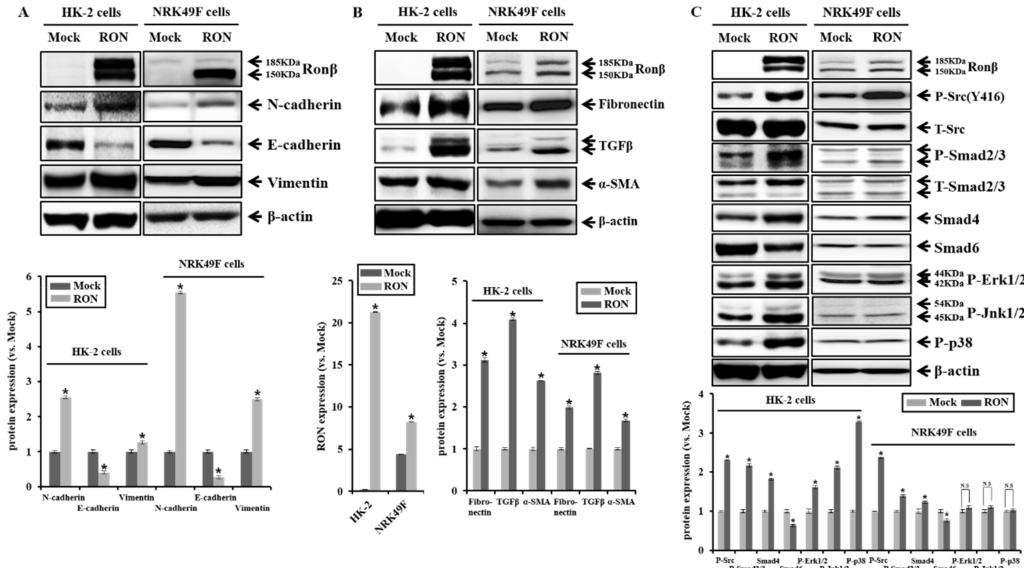
Figure 2. E ff ects of recepteur d’origine nantais (RON) overexpression on EMT, pro-fibrotic marker, and the Src signaling pathway in HK-2 and NRK49F cells. ( A ) Protein expression of the N-cadherin, E-cadherin, and vimentin by RON overexpression was analyzed. ( B ) Protein expression of fibronectin, TGF β , and α -SMA by RON overexpression was analyzed. ( C ) Protein expression of phosphorylated Src (Y416) was assessed in RON overexpression and controls. Protein expression of the phosphorylated Smad2 / 3, Smad4, and Smad6 by RON overexpression was analyzed. Protein expression of phosphorylated ERK (P-ERK), phosphorylated JNK (P-JNK), phosphorylated P38 (P-p38) was assessed in RON overexpression and controls. Each column represents the mean ± SEM. * p < 0.05, compared with the Mock. N.S, statistically not